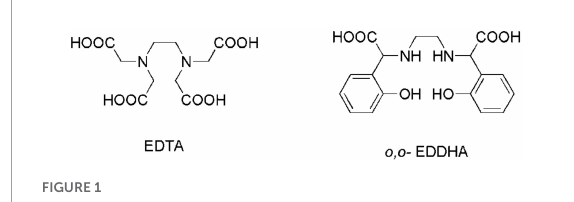
FIGURE1 Molecular structures of EDTA and o , o